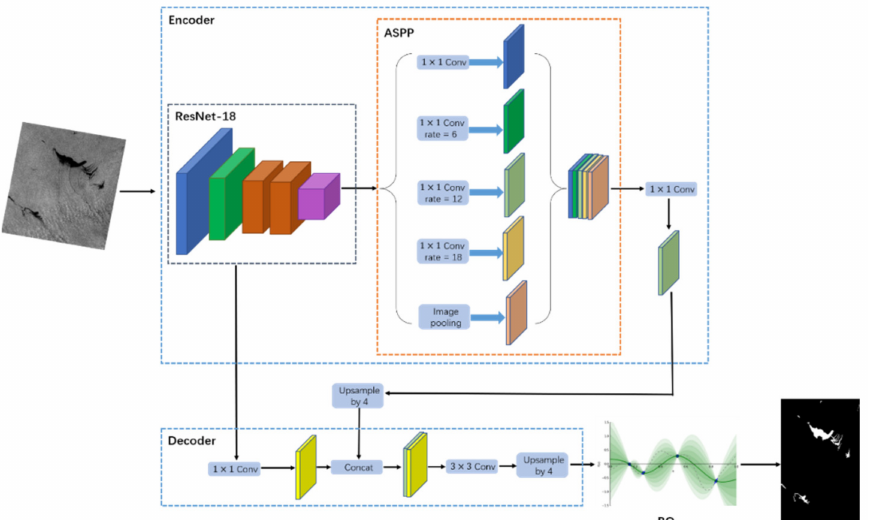
Figure 1. Structure depiction of the proposed BO-DRNet for oil spill detection. BO-DRNet’s encoder includes ResNet-18 and ASPP. BO was used in BO-DRNet. Conv stands for a convolutional layer in ASPP and